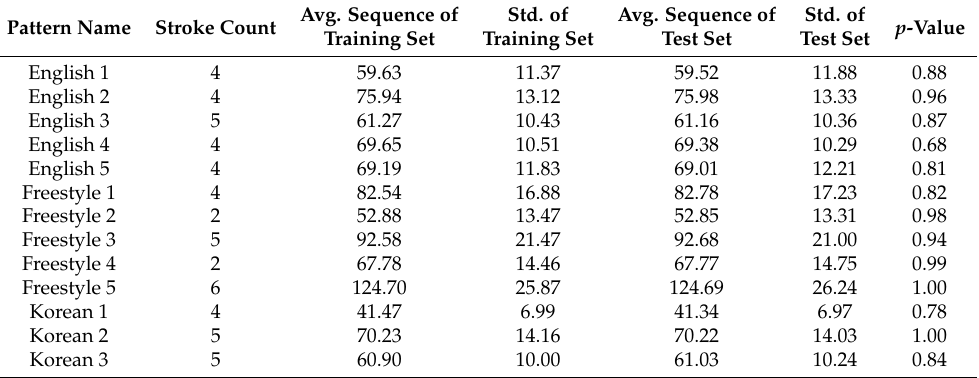
Table 7. Statistics pertaining to training and test data from each collected drawing dataset.